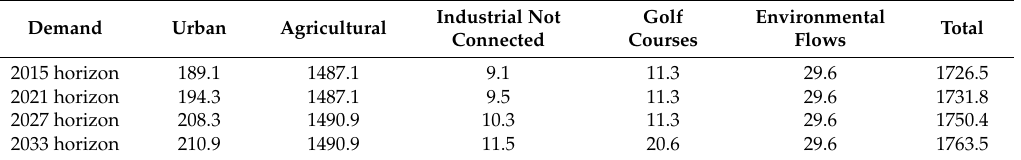
Table 1. Current and future demands in the Segura River Basin (hm 3